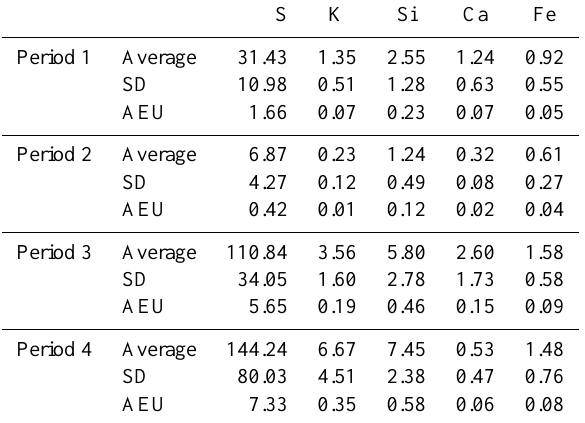
Table 2. Summary statistics for DRUM Impactor sampled species by inferred period. Size fraction is 0.34–1.15µm. All values are in units of mass concentration ngm − 3 . “SD” means standard devia- tion. “AEU” means Average Experimental Uncertainty.